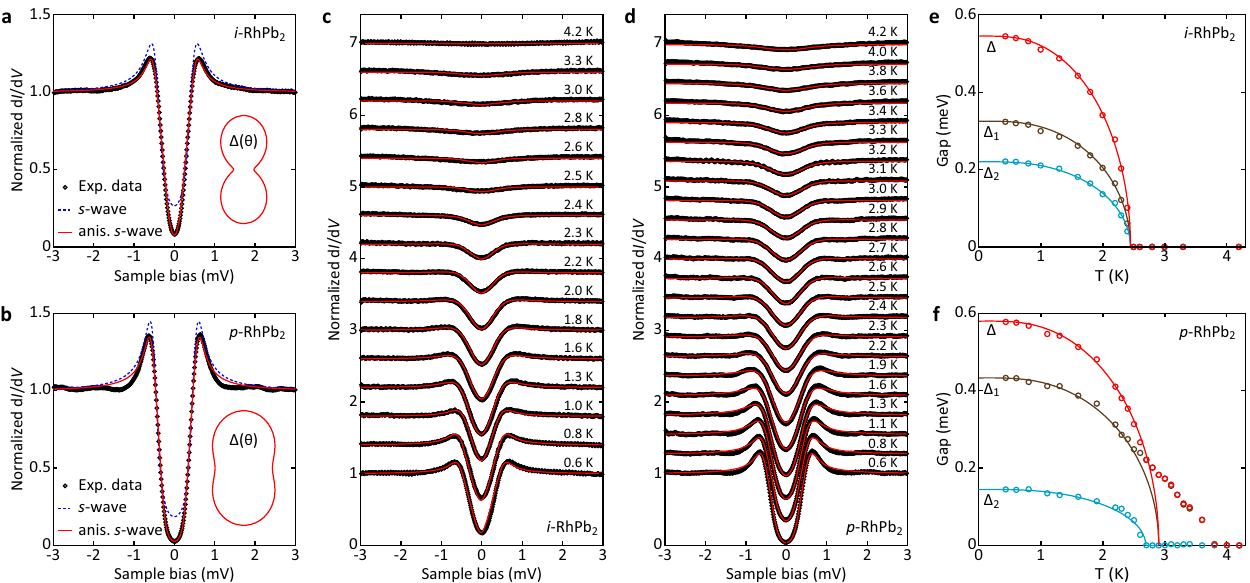
Fig. 2 Temperature-dependent d I /d V spectra of RhPb2 without/with proximal superconductor Pb. a , b Normalized d I /d V spectra (setpoint: fi ts of the experimental data (empty circles) to V = 3 mV, I = 500 pA) on i - and p -RhPb 2 at 0.4 K, respectively. The colored lines show the best the Dynes model with isotropic (blue dashed lines) and anisotropic (red solid lines) s -wave gap functions. Insets show the polar plot of the superconducting gap Δ as a function of θ . The normalization was performed by dividing the raw tunneling d I /d V spectra by their backgrounds, extracted from a linear fi t to the conductance beyond the superconducting gaps. c , d Dependence of d I /d V spectra on temperature as indicated on both i - and p -RhPb 2 , respectively. The red lines describe the best fi ts to anisotropic s -wave gap functions. The spectra have been offset vertically on the d I /d V intensity axis for clarity. e , f Temperature-dependent superconducting gap parameters of Δ (red), the isotropic component Δ 1 (brown) and anisotropic component Δ 2 (cyan) on i - and p -RhPb 2 fi lms, respectively. Solid lines represent the fi tting by the BCS gap